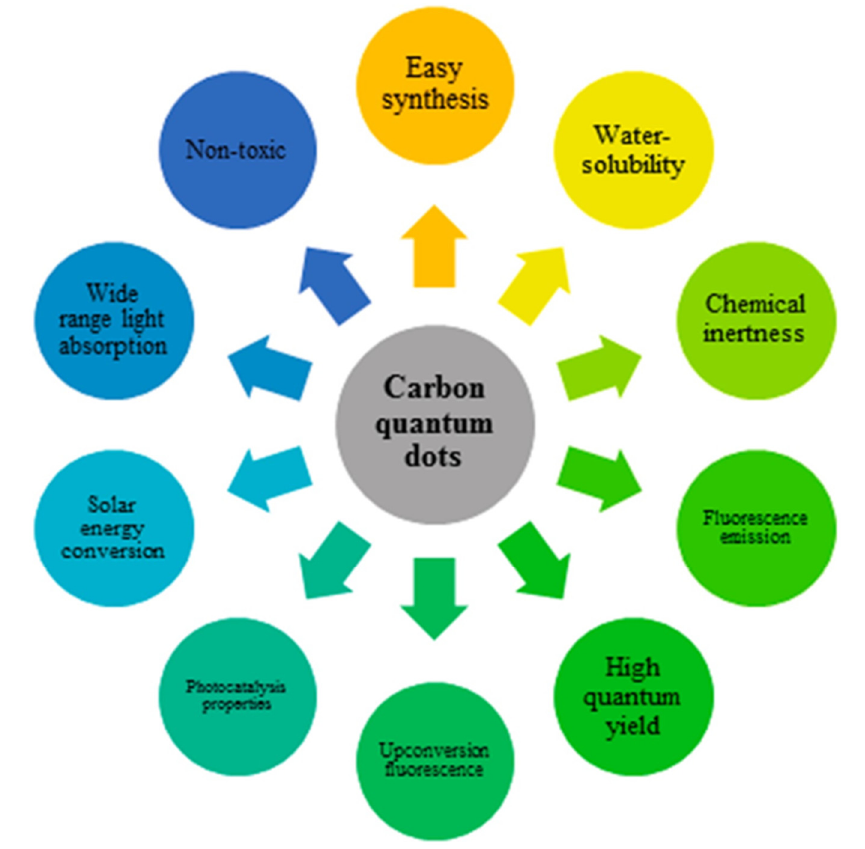
Figure 1. Carbon quantum dots (CDs) properties. Reprinted with the permission of Reference [19].